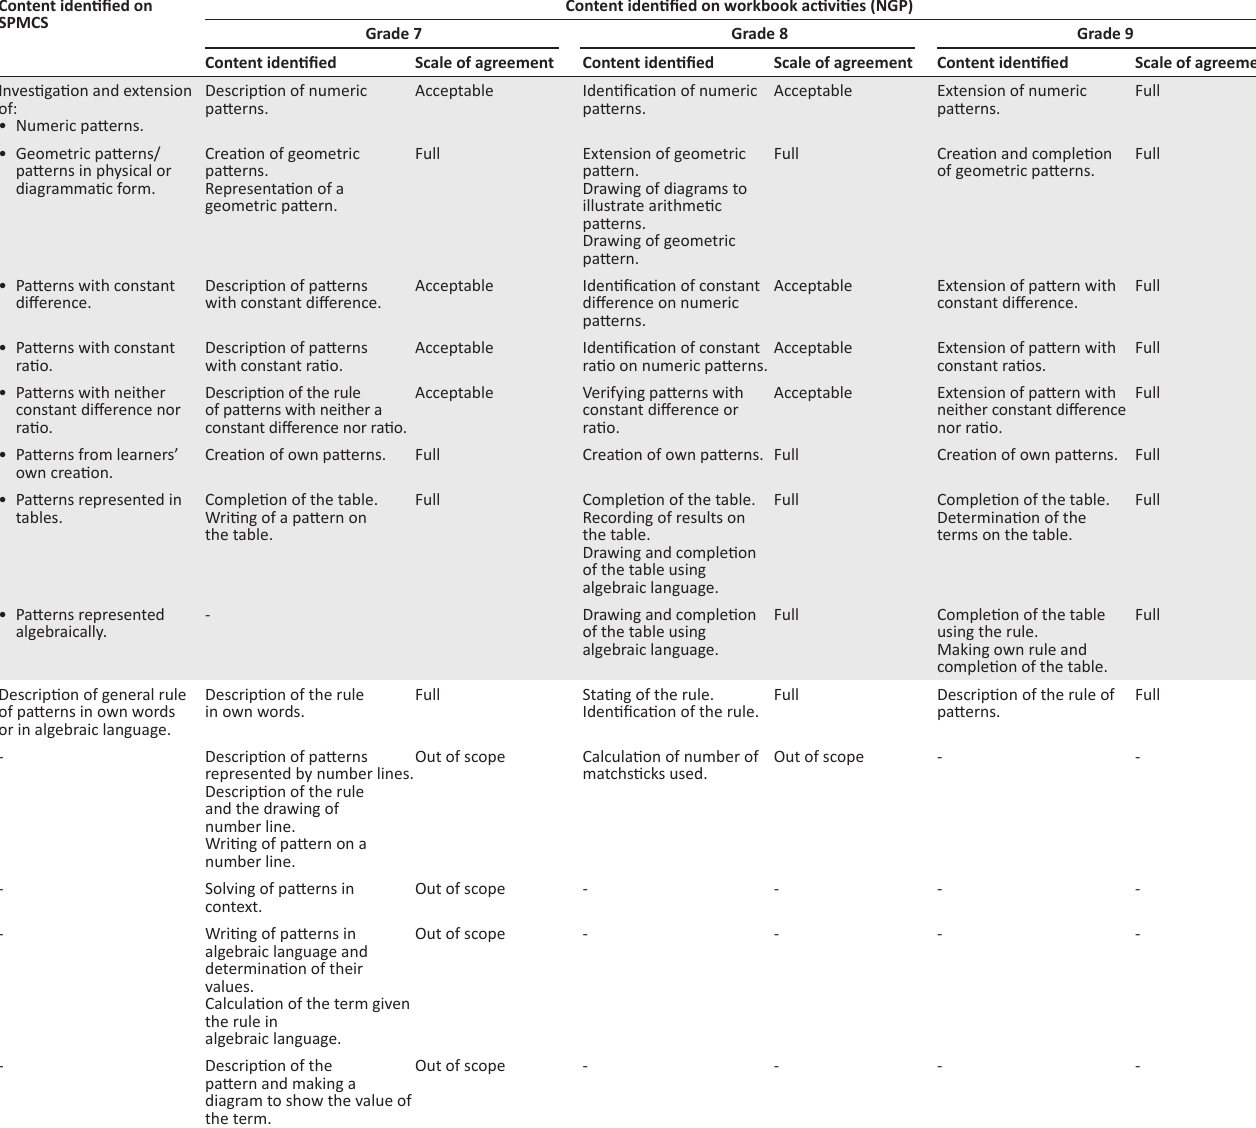
TABLE 1: Grades 7–9 categorical concurrence and scale of agreement. Content identified on